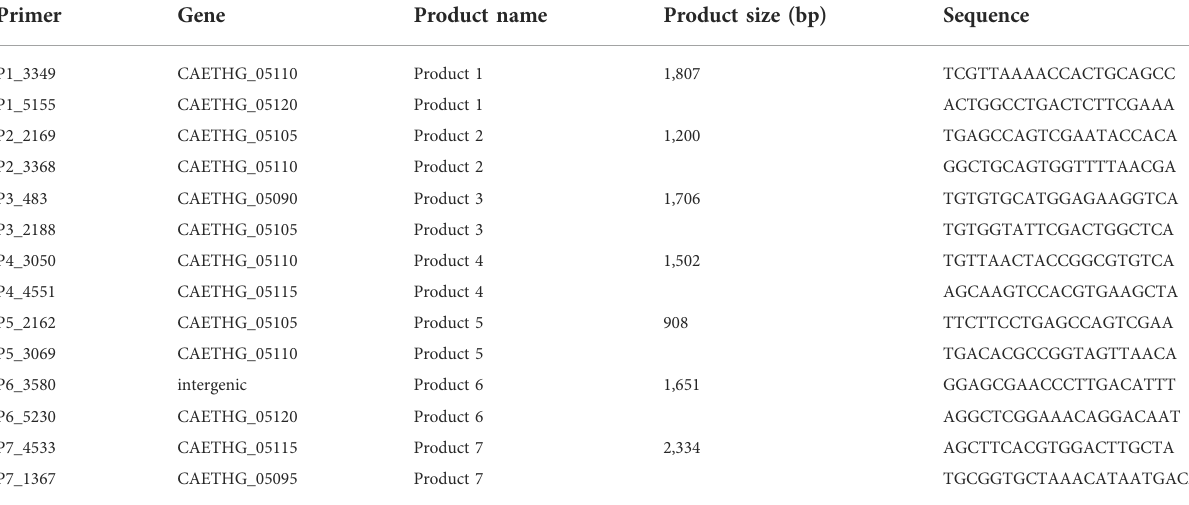
TABLE 2 Oligonucleotides used to con fi rm plasmids via overlapping PCR reactions.